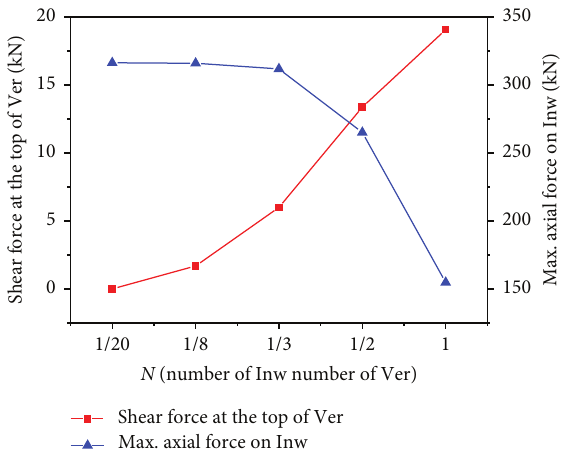
Figure 21: Comparison of the shear force at the top of vertical piles and the maximum axial force acting on inclined piles in VIIP with different N values.